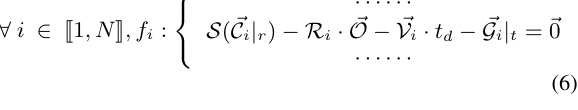
Figure 12: Residuals of lever-arm and delay estimation using ground control points